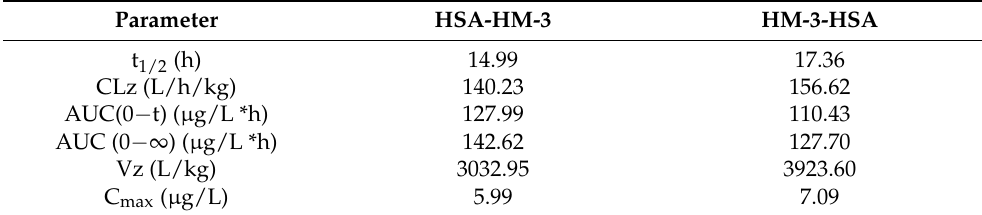
Table 3. Pharmacokinetic parameters of HM-3/HSA after a single administration in KM mice *.